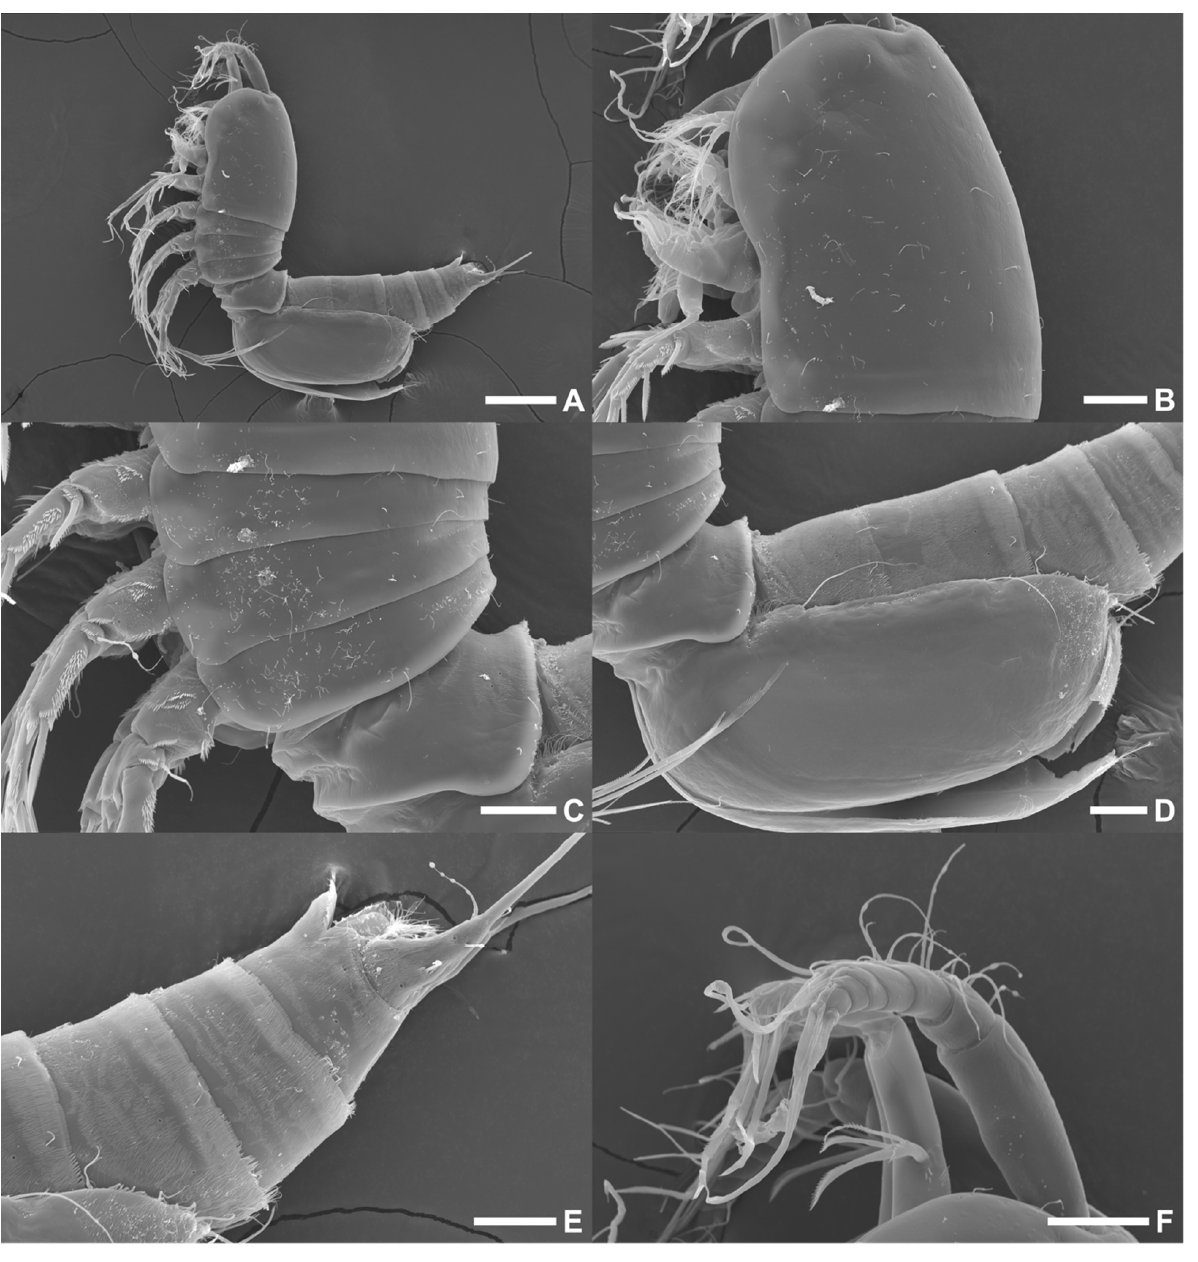
Figure 22. Scanning electron microscopy images of Phyllopodopsyllus similis sp. nov. female (paratype 3) in lateral view: ( A ) habitus; ( B ) cephalothorax; ( C ) second prosomite to first urosomite; ( D ) P5 and genital double-somite; ( E ) third urosomite to caudal rami; ( F ) antennule and antenna. Scale bars: ( A ) 100 µ m; ( B – F ) 30 µ